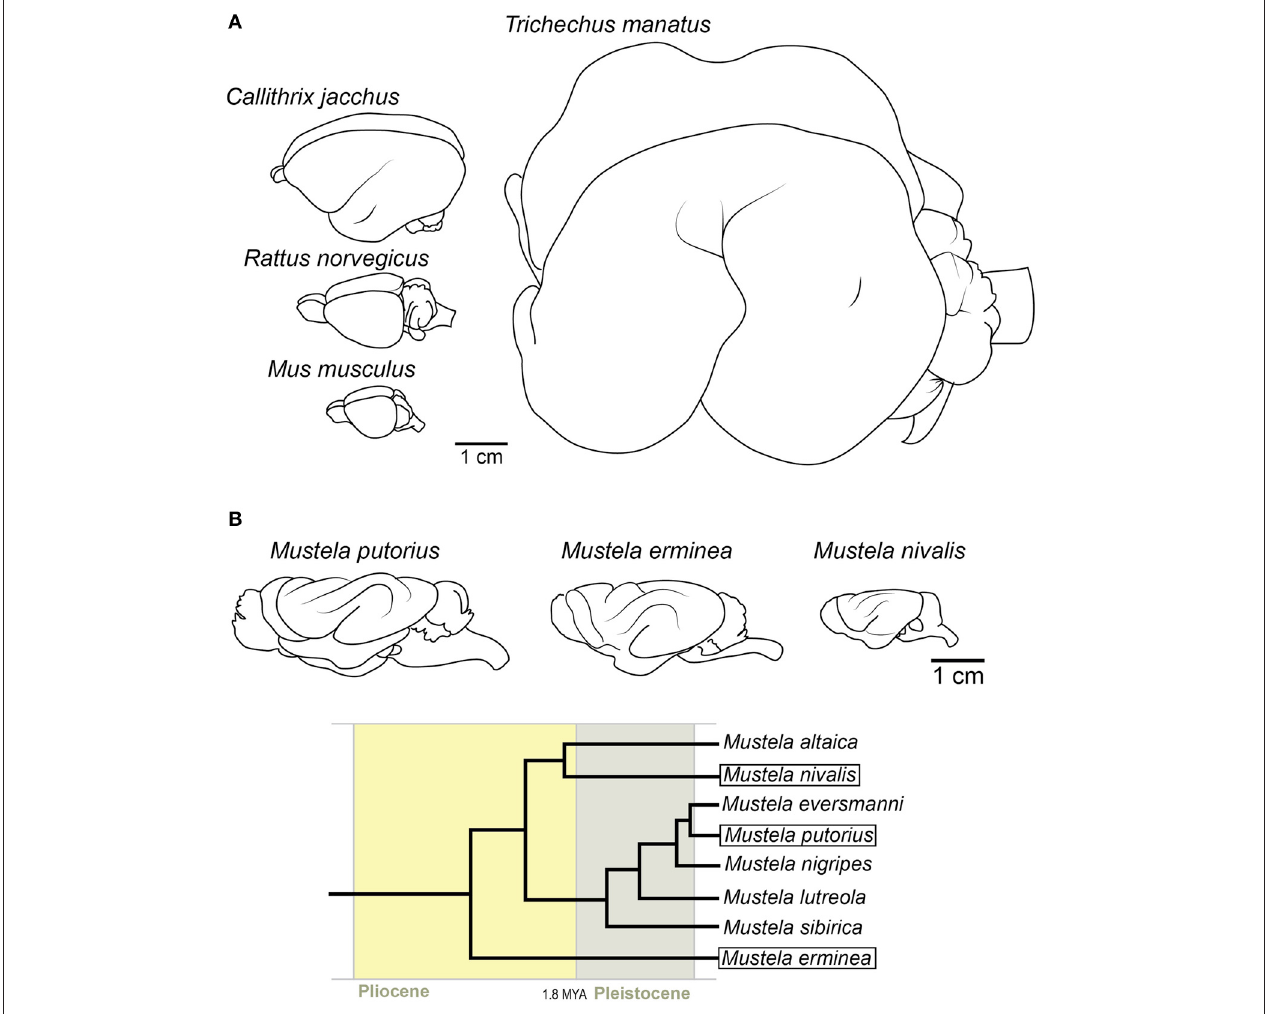
FIGURE 3 | Examples of potentially secondarily lissencephalic brains. (A) Top left: Common marmoset, middle left: rat, bottom left: mouse. Right: West Indian manatee. (B) Brains of three extant mustelid species. Note the simplification of the gyrification